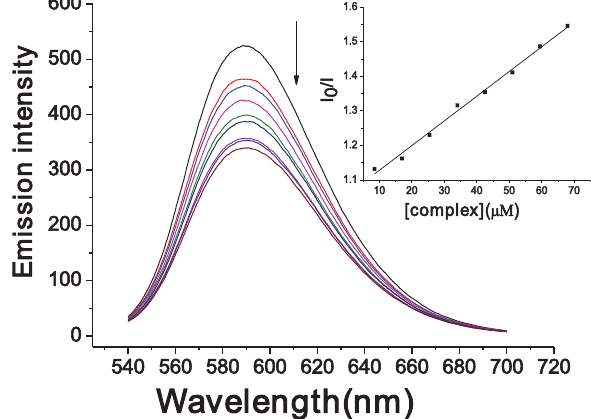
Figure 3: Electronic absorption spectra of the complex upon the titration of HS-DNA. Arrow indicates the change upon increasing the DNA concentrations. Inset: [DNA]/( ε